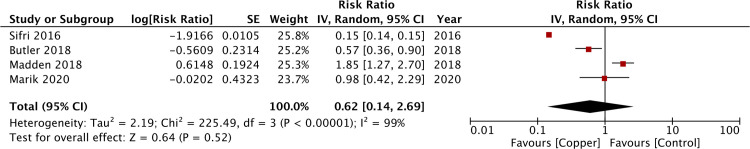
Forest plot of HAI of Clostridioides difficile infection for copper-impregnated linen vs regular linen.